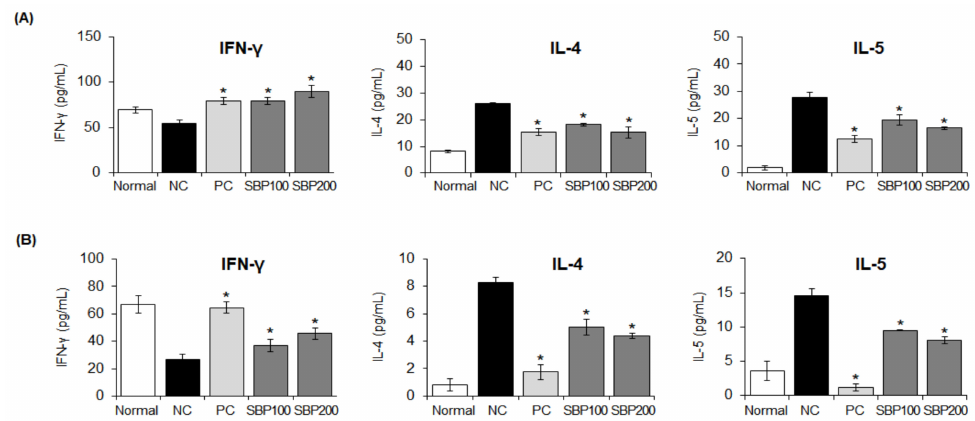
Effect of the SBP extract on T cell − differentiation cytokine production in OVA/Alum − sensitized mice. ( A ) bronchoalveolar fluid and ( B ) plasma. Data are expressed as mean ± SEM. Significantly different from the NC group (* p < 0.05). SBP, sword bean pod; NC, negative control; PC, positive